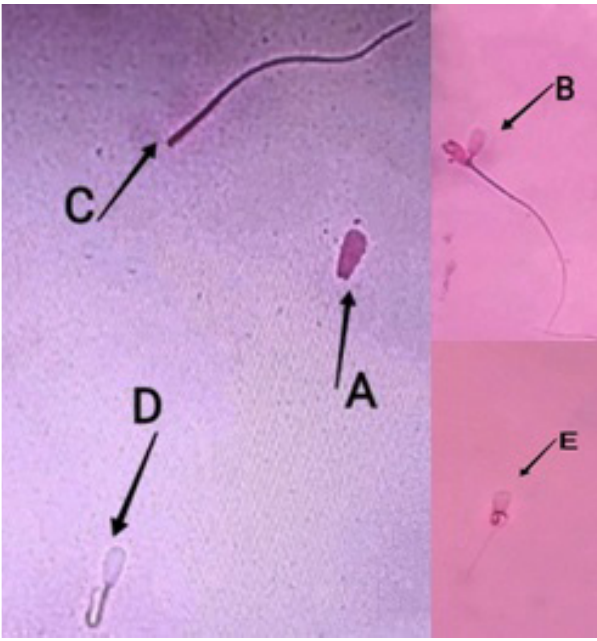
Figure 3. Sperm abnormalities of Bali bulls. (A) No tail, (B) double-headed, (C) broken tail, (D) short tail, (E) coiled tail.